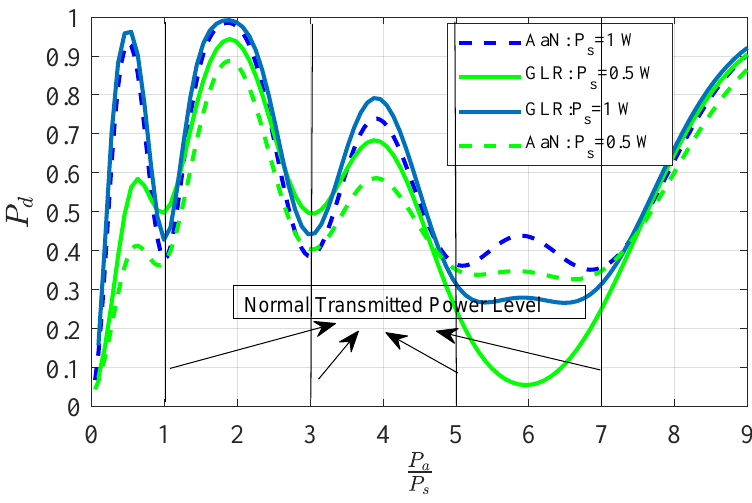
Figure 7. Detection probability under multiple power levels. The AaN detector can well replace the GLR detector in most intervals at the expense of less than 10% detection probability.